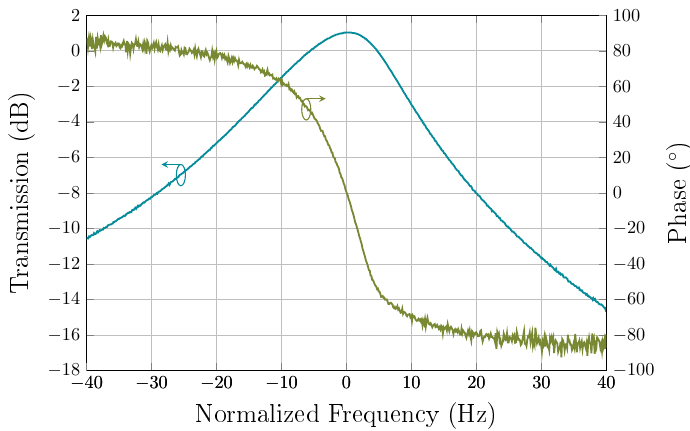
Figure 11. Measured open-loop gain and phase shift of the oscillator loop under vacuum at a polarization voltage of